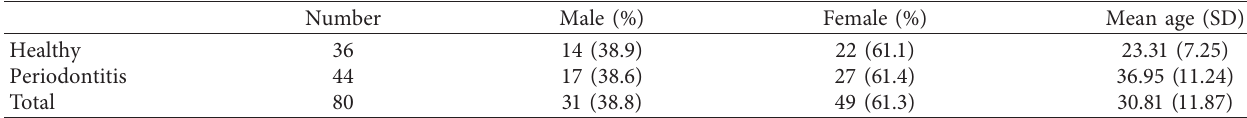
Table 1: Demographic information of study participants.